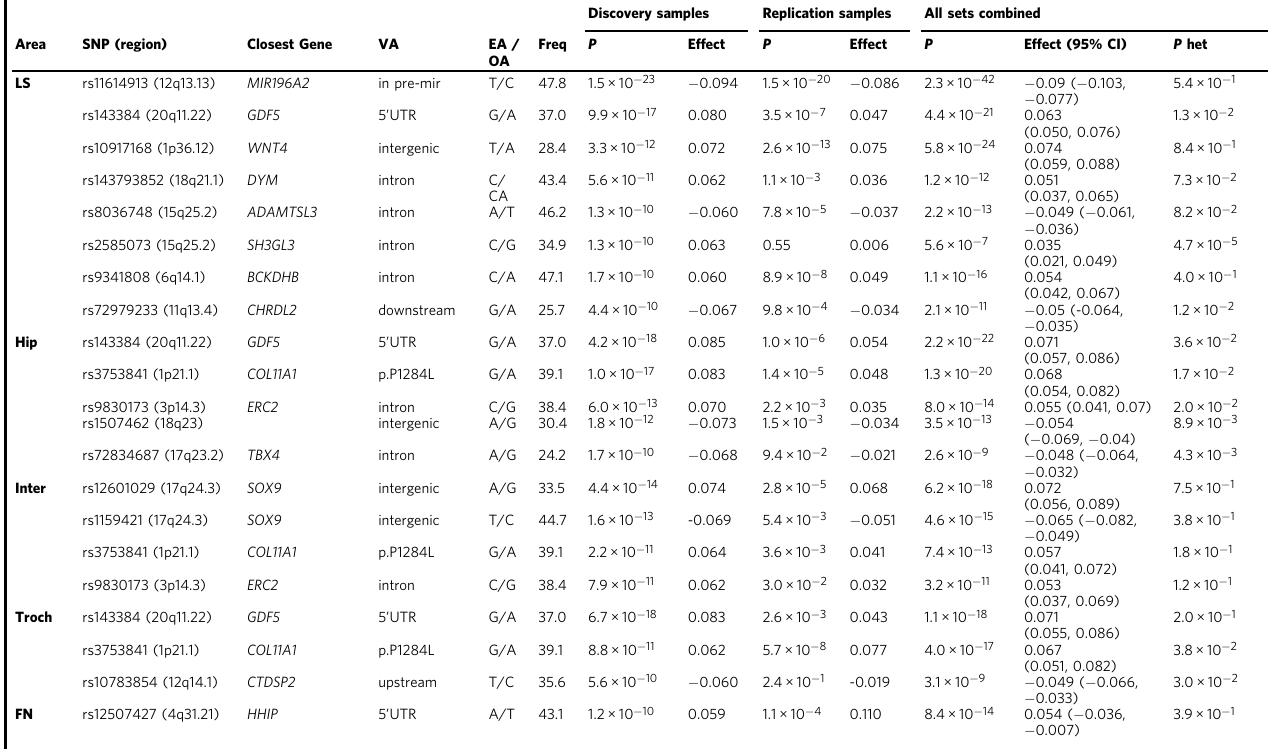
Table 1 GWS DXA bone area variants in the Icelandic discovery samples Discovery samples Replication samples All sets